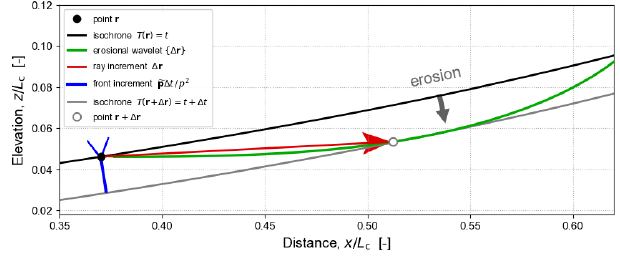
) described by H and L , 2